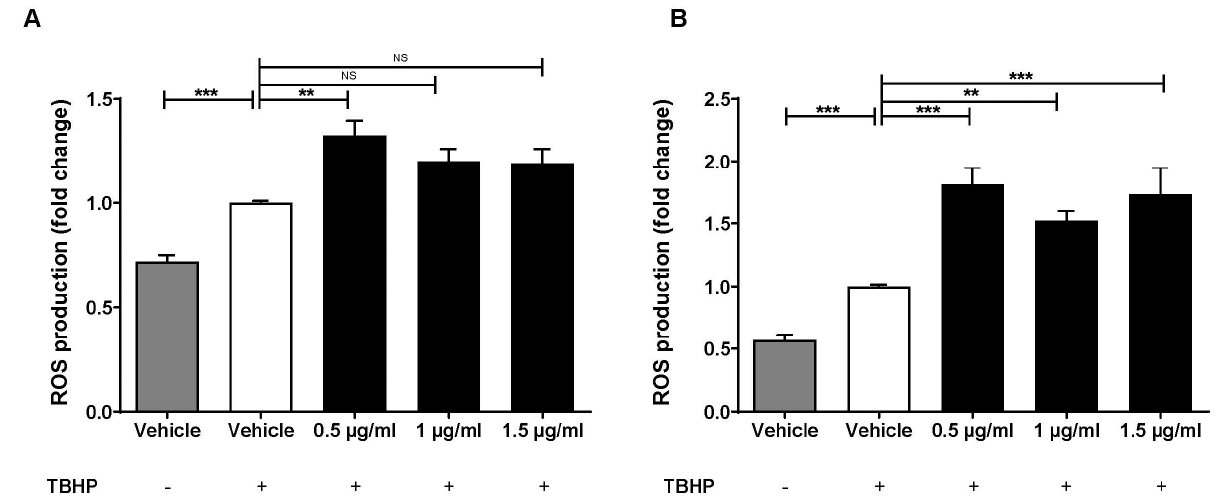
Figure 2. Lab4b CM increases TBHP-induced ROS production in human monocytes and macrophages. THP-1 monocytes ( A ) and macrophages ( B ) were treated with 50 μ M TBHP and either vehicle or three different concentrations of Lab4b CM, as shown (0.5 μ g/mL, 1 μ g/mL and 1.5 μ g/mL). Cells treated with vehicle but in the absence of TBHP were also included for comparative purposes. ROS production is shown as fold change to the vehicle control with TBHP, which was arbitrarily assigned as 1. Data are mean ± SEM from five independent experiments, and statistical analysis was carried out on sine – transformed ( A ) or log transformed ( B ) data using one-way ANOVA with the Bonferroni post-hoc test (**, p ≤ 0.01; ***, p ≤ 0.001; NS, not significant).